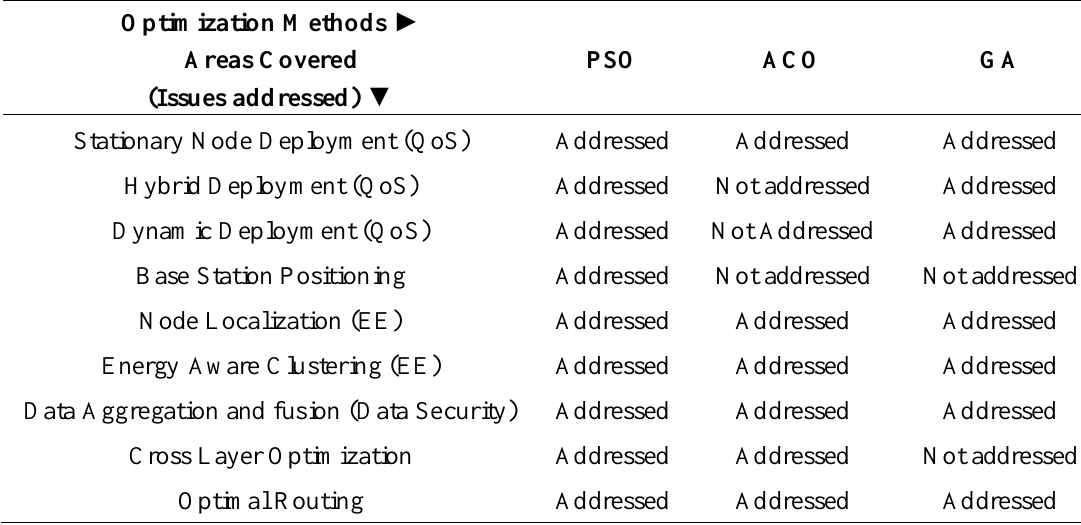
Table 5. A summary of major bio-mimetic optimization methods in